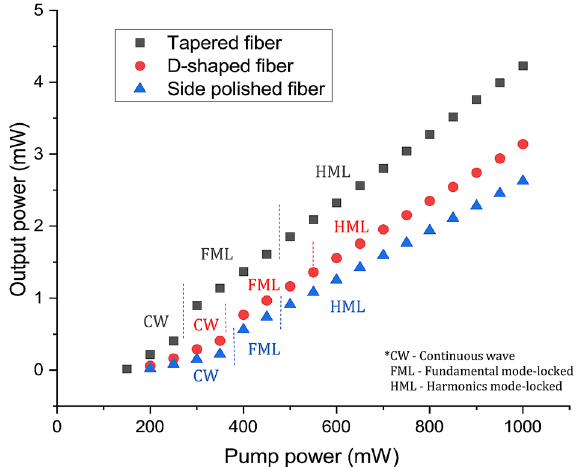
Figure 15. The pump power versus the output power of the mode-locked TDFLs.